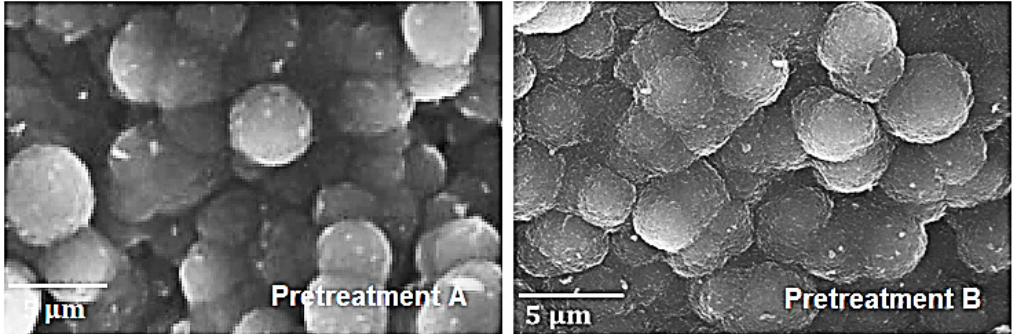
Figure 6. Top surface of the coked Ti–base alloy after application of pretreatment A and pretreatment B, and seven coking/decoking cycles followed by a 6 h coking at an accelerating voltage of 20 kV.